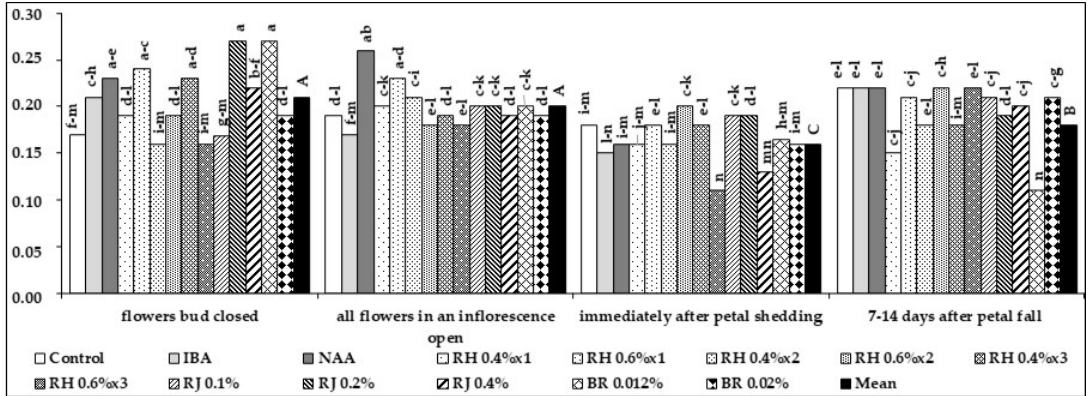
Figure 9. The influence of rooting enhancers on chlorophyll b content (mg g − 1 FW) in leaves of Rosa ‘Maiden’s Blush’ cuttings harvested from shoots in four phenological stages of shoots. Control—the control cuttings; IBA 0.4%—Ukorzeniacz A aqua (0.4% IBA); NAA 0.2%—Ukorzeniacz B aqua (0.2%